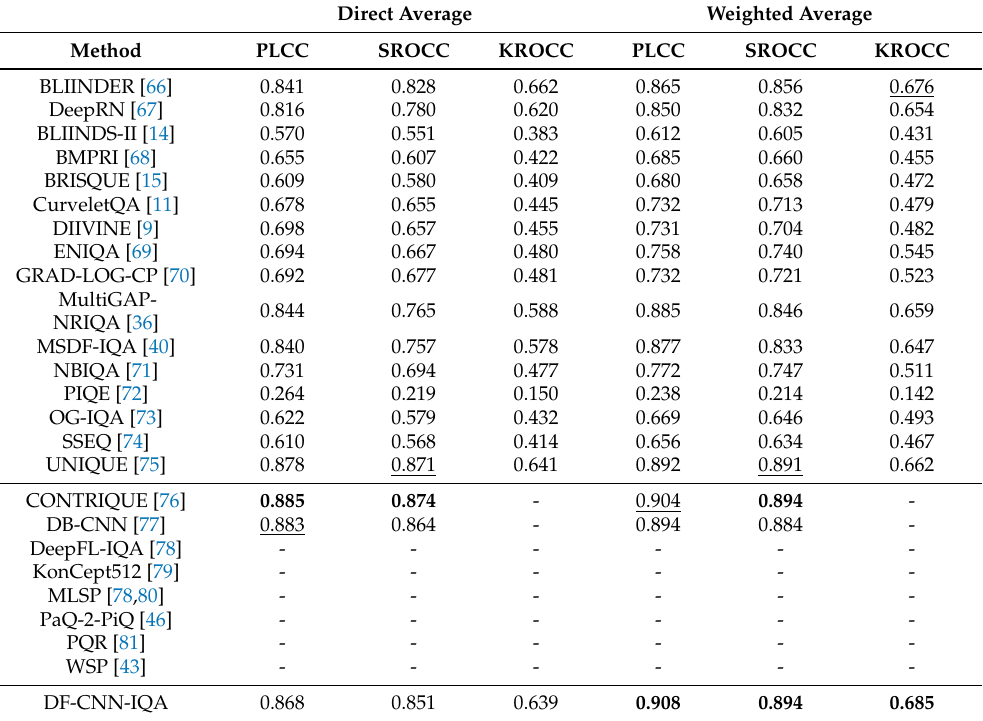
Table 6. Comparison of the proposed DF-CNN-IQA to the state of the art. The weighted and direct average of measured PLCC and SROCC values are reported. The best results are typed in bold , and the second-best results are underlined. We denoted by ‘-’ if the data were not available.